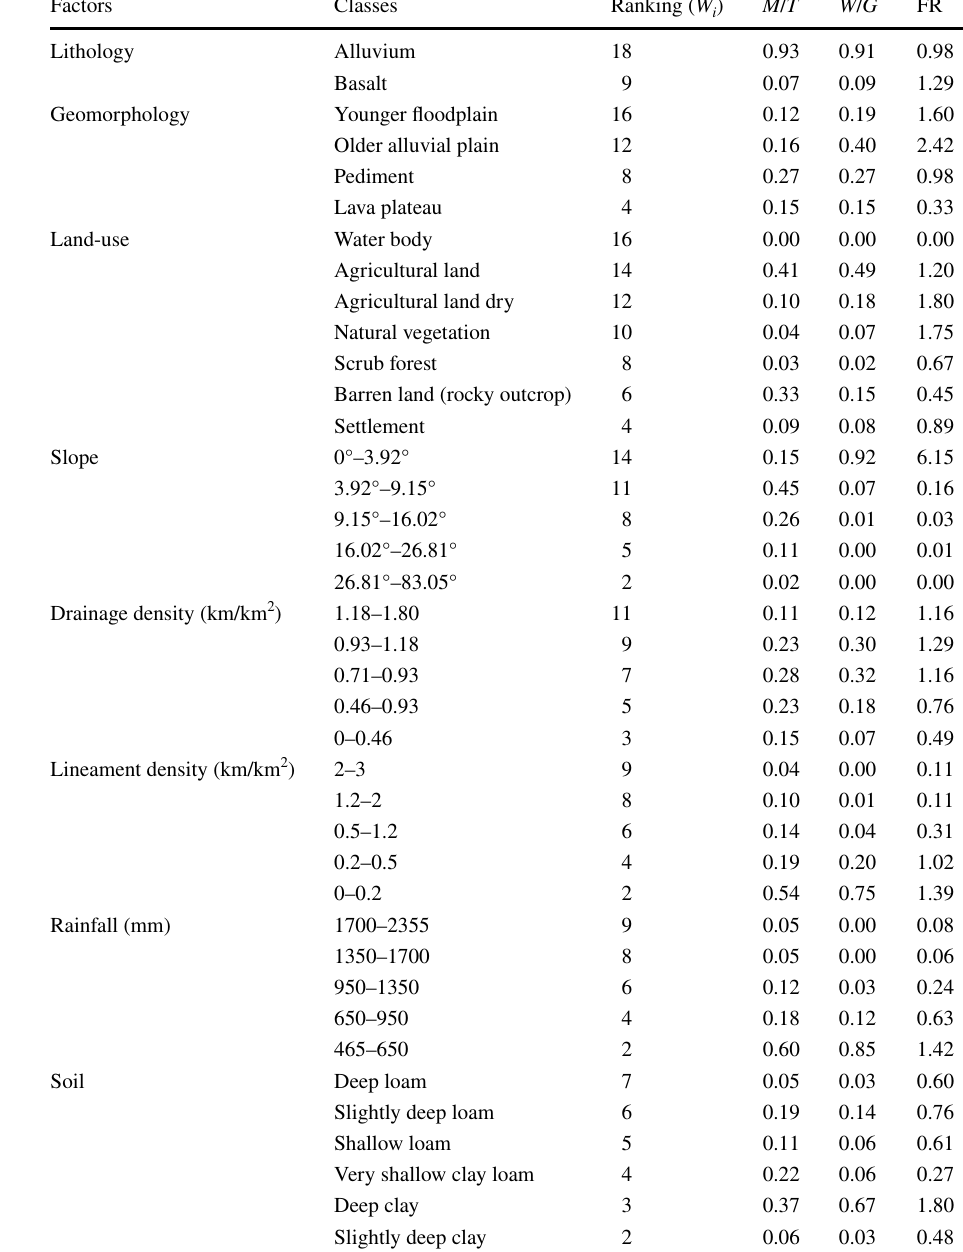
Table 2 Classification of weighted factors and their corresponding ranks to delineate groundwater potential zones